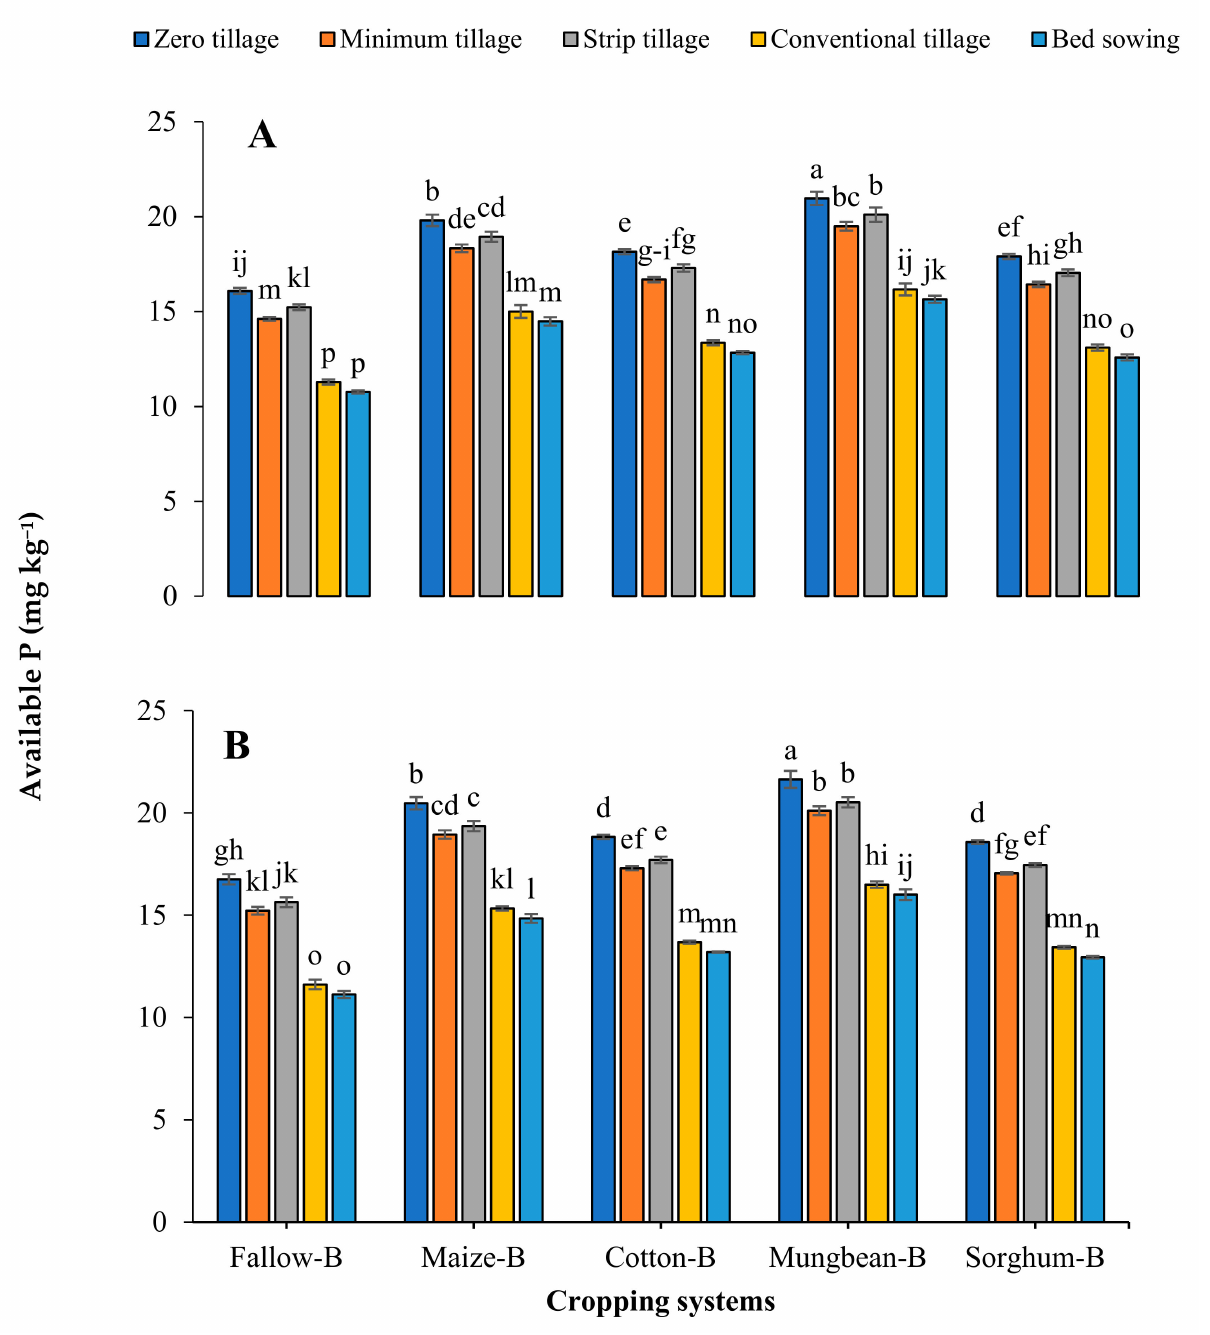
Figure 3. Interactive effect of tillage systems and barley-based cropping systems on soil available P (mg kg − 1 ) after barley harvest during 2017–2018 ( A ) and 2018–2019 ( B ) ± S.E. In the legend, Fallow-B = Fallow-barley, Maize-B = Maize-barley, Cotton-B = Cotton-barley, Mungbean-B = Mungbean-barley and Sorghum-B = Sorghum-barley. The means sharing same letters do not differ significantly ( p > 0.05). LSD 0.05 (2017–2018 = 0.65, 2018–2019 =